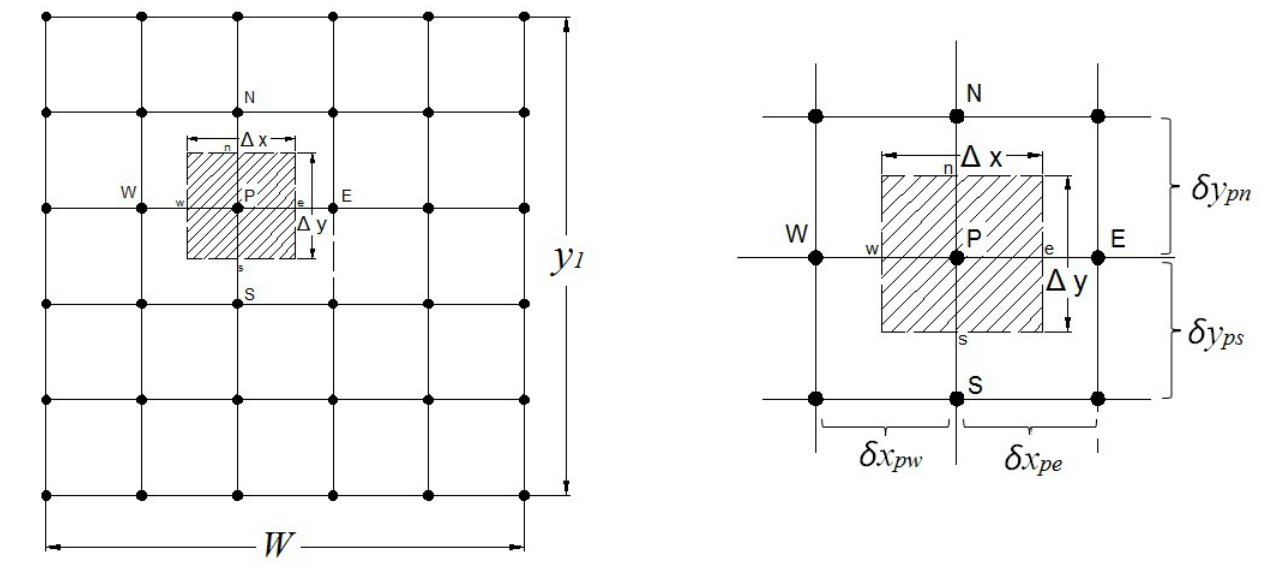
Figure 2. A control volume in the computational